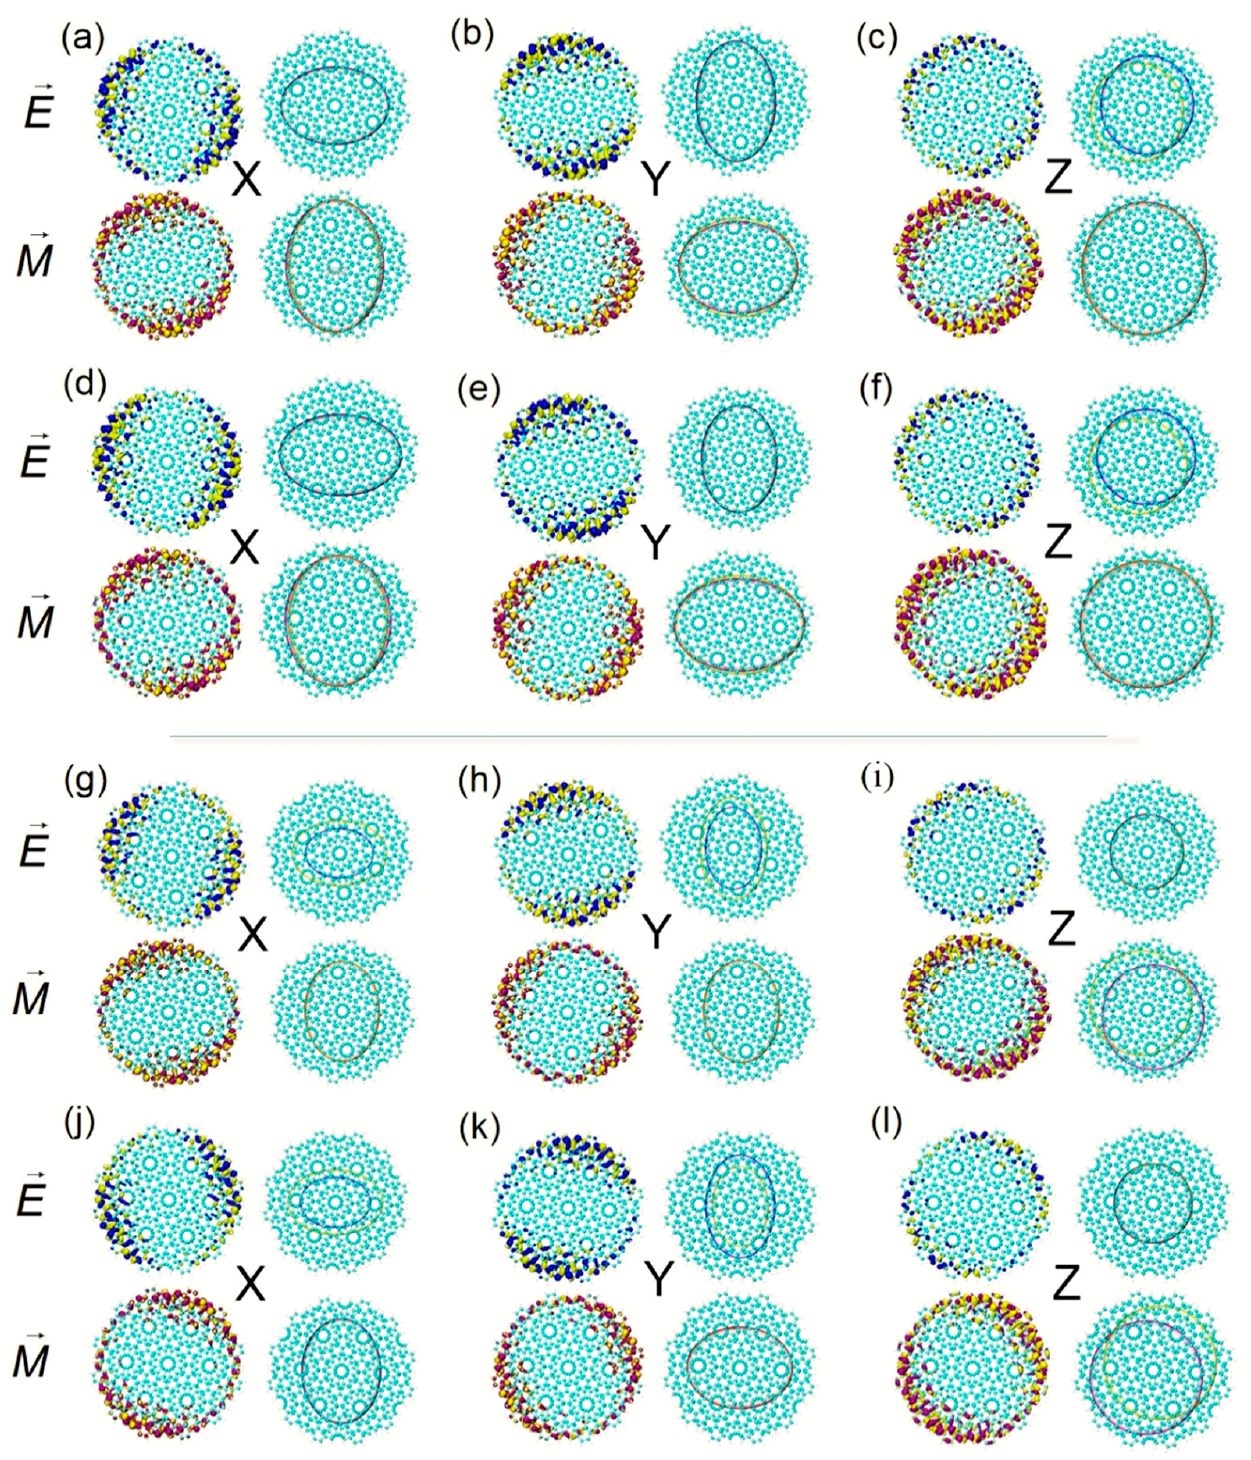
Figure 3. The theoretical calculation of TEDM (yellow isosurface represents a negative value, blue isosurface represents positive value) and TMDM (yellow isosurface represents a negative value, purple isosurface represents positive value) of Z-TwBLG-QDs-27.8 ◦ at S 47 and its TEDM S and TMDM S of Cartesian components ( a – c ), respectively. TEDM and TMDM of Z-TwBLG-QDs-32.2 ◦ at S 48 and its TEDM S and TMDM S of Cartesian components ( d – f ), respectively. TEDM and TMDM of Z-TwBLG-QDs-27.8 ◦ and Z-TwBLG-QDs-32.2 ◦ at S 49, and their TEDM S and TMDM S of Cartesian components ( g – i , j – l ),